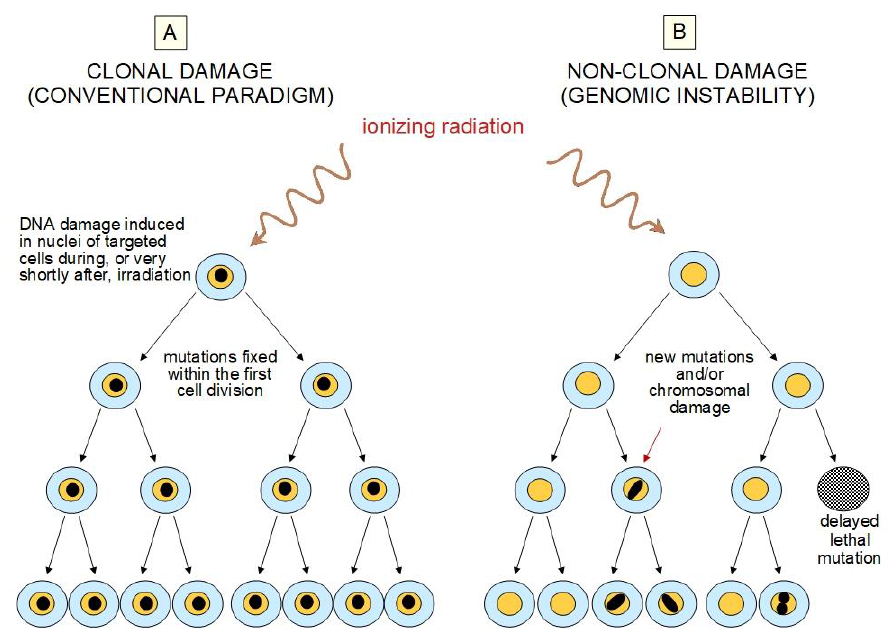
Figure 3. Schematic description of two possible ways for radiation-induced damage propagation in the progeny of irradiated cells: ( A ) according to the conventional paradigm of radiobiology, damage is induced during, or shortly after, irradiation, and clonally propagates to the progeny; ( B ) by genomic instability, a non-clonal effects that is observed as new mutations and/or new chromosomal damage in the unirradiated progeny of the irradiated cell.